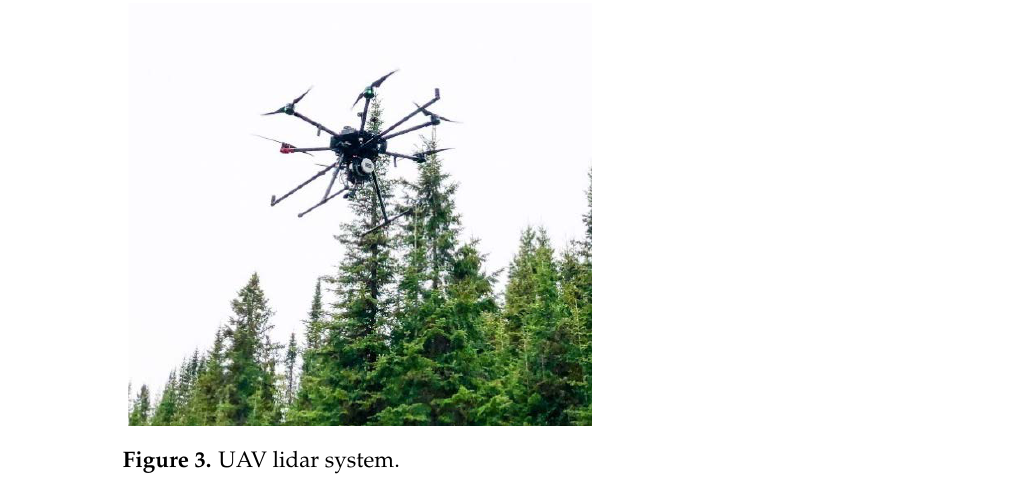
Figure 2. ( a ) Sainte-Marthe site during summer survey and ( b ) during winter survey; ( c ) presence of basal ice layer in Sainte-Marthe field; ( d ) Saint-Maurice site during summer survey and ( e ) during winter survey; ( f ) Montmorency site during summer survey and ( g ) during winter survey; ( h ) local snow accumulation in a forest gap in Montmorency boreal forest.